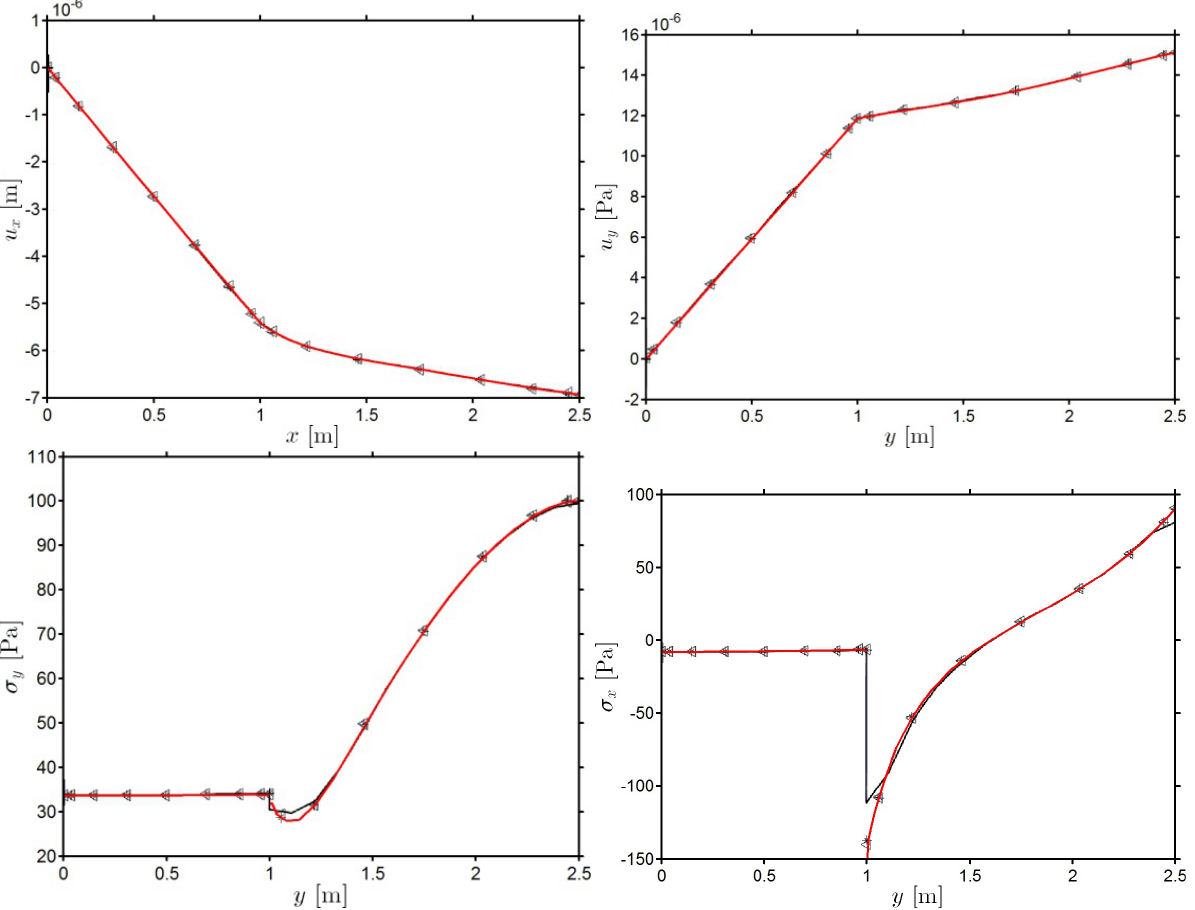
Figure 15: The present result using N = M = 21 for each element is compared to the same presented by Zong and Zhang [122], who solved the problem using multi-domain DQ and FEM (Abaqus).